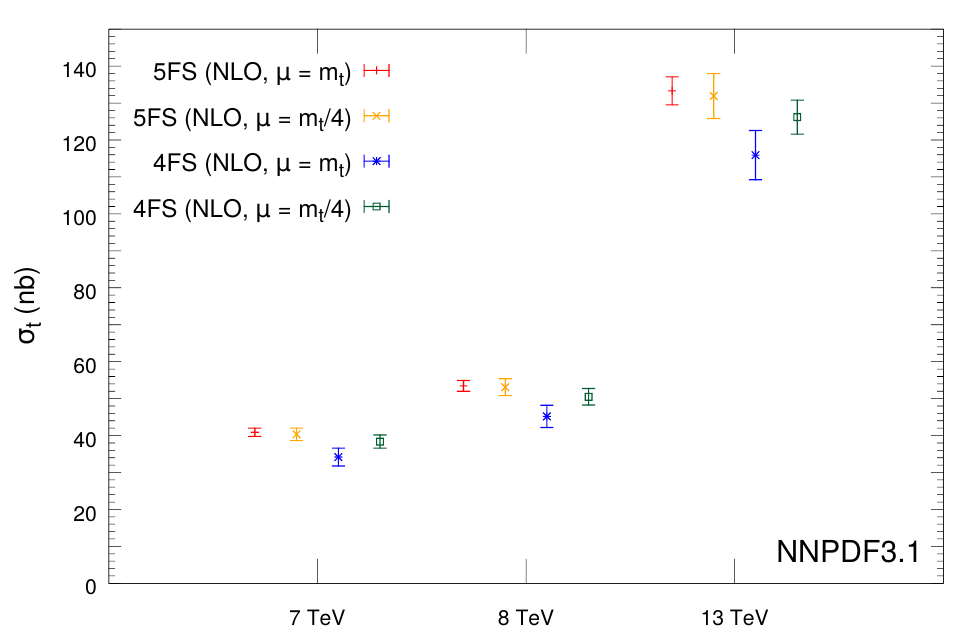
Figure 6 . Comparison between total cross section predictions at NLO in the 5FS and in the 4FS for (cid:22) f = (cid:22) r = m t and for (cid:22) f = (cid:22) r = m t = 4. The uncertainty of the theoretical predictions represent the envelope of 7-point scale